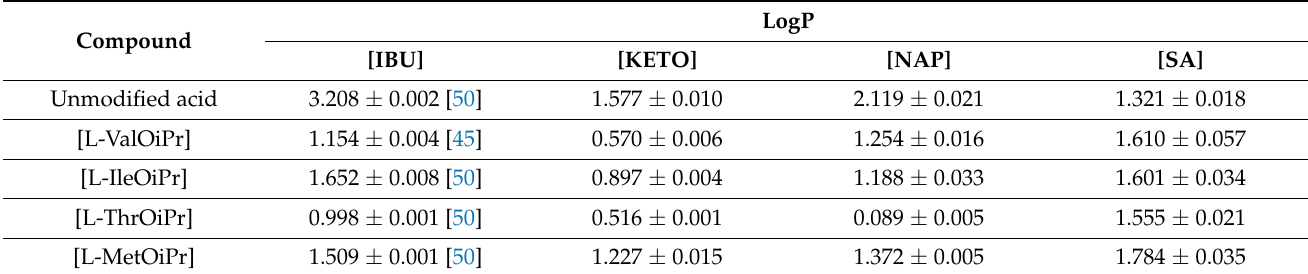
Table 4. The n-octanol-water partition coefficient (logP) of acids from NSAID groups and their L-amino acid isopropyl ester